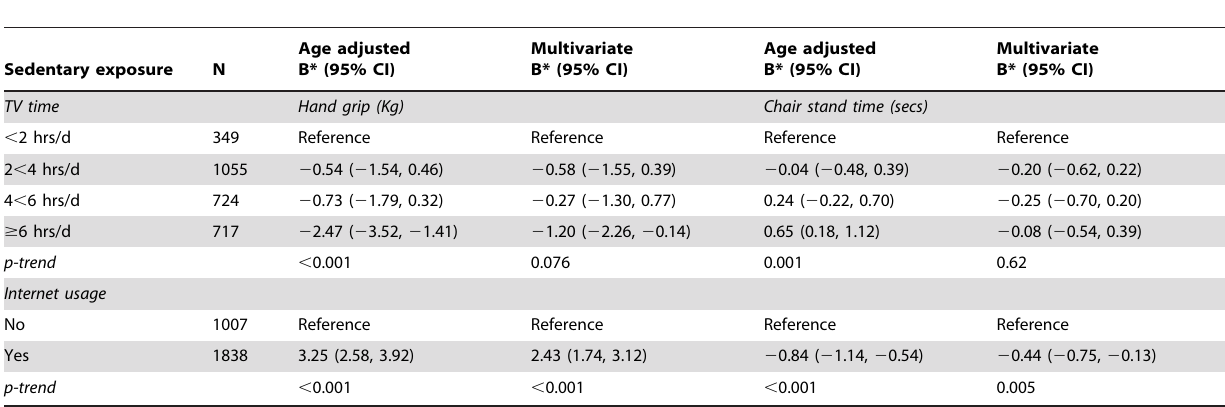
Table 2. The association between TV time, internet use and muscle strength indicators in men (N= 2845).